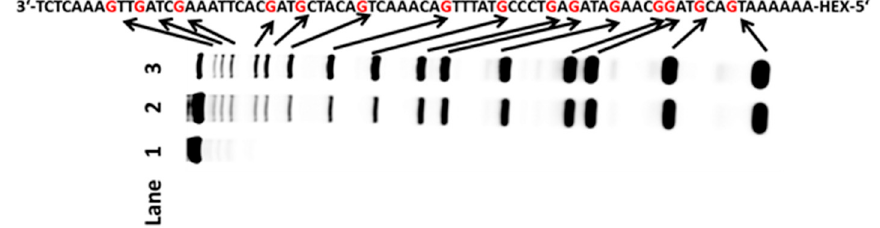
Figure 3. Polyacrylamide gel electrophoresis analysis of 76-mer DNA. The ODN (20 pmol) was oxidized by AP and then treated with piperidine. Lane 1: DNA alone; lane 2: DNA treated with AP; lane 3: G-ladder of ODN (treated with DMS).